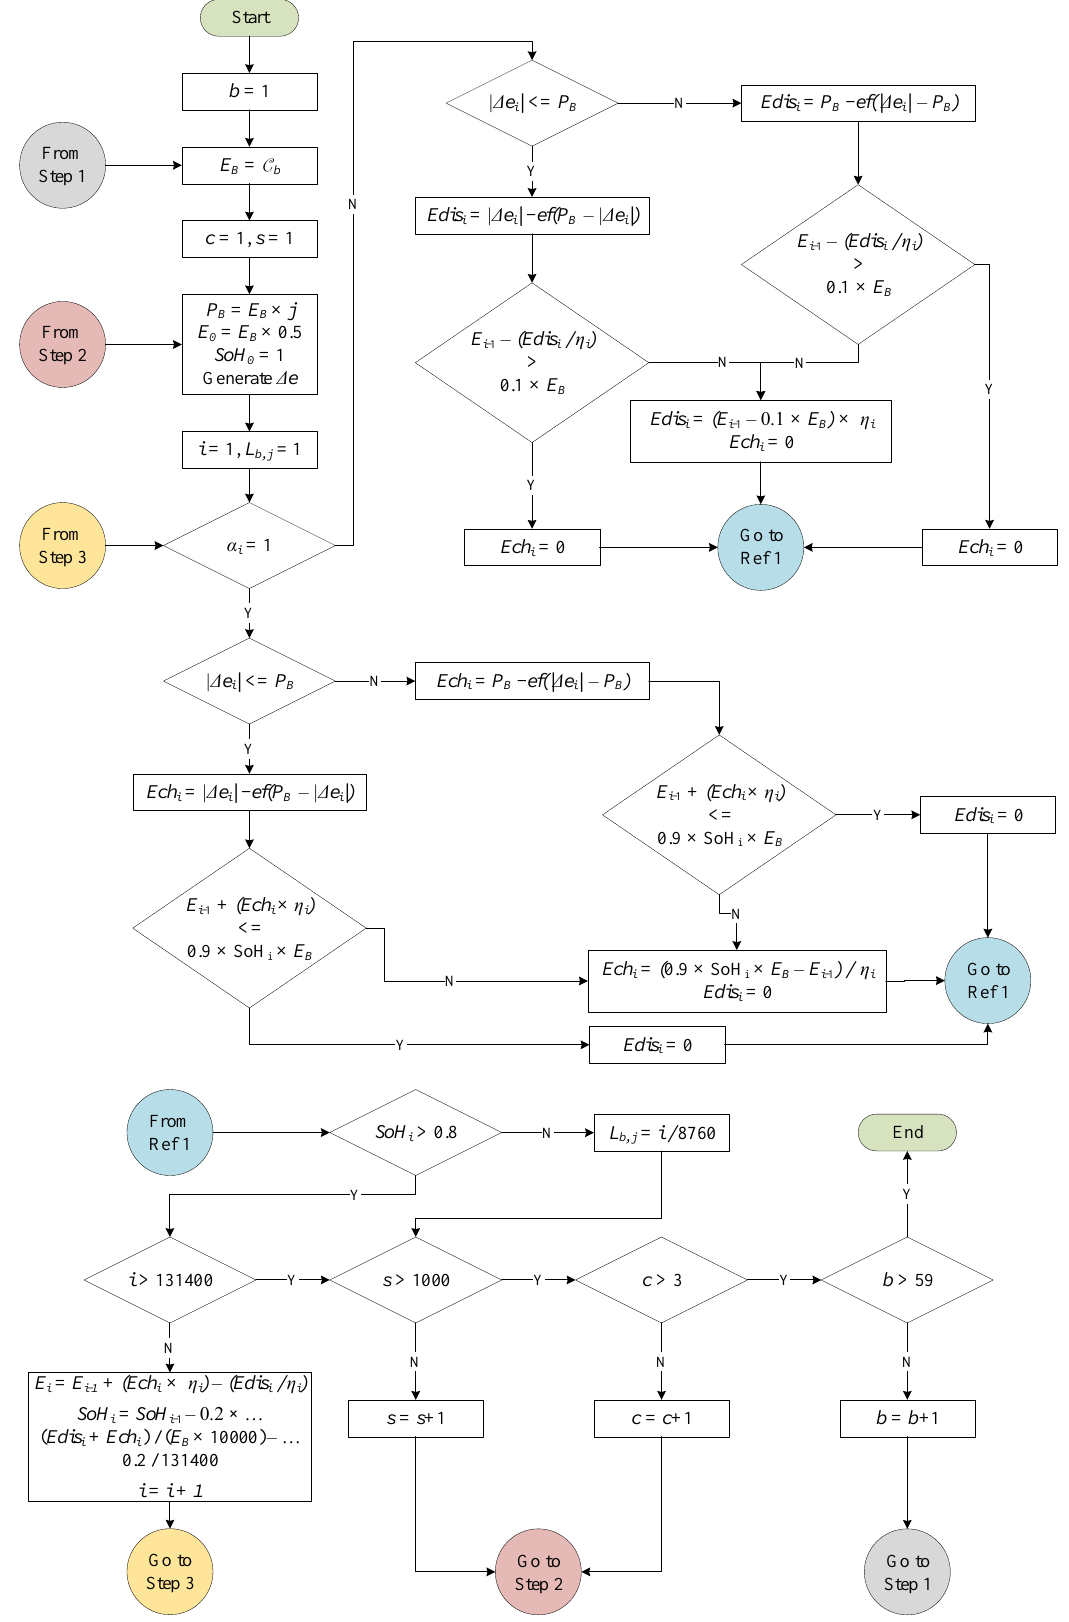
Figure 16. Flowchart of the proposed method in Section